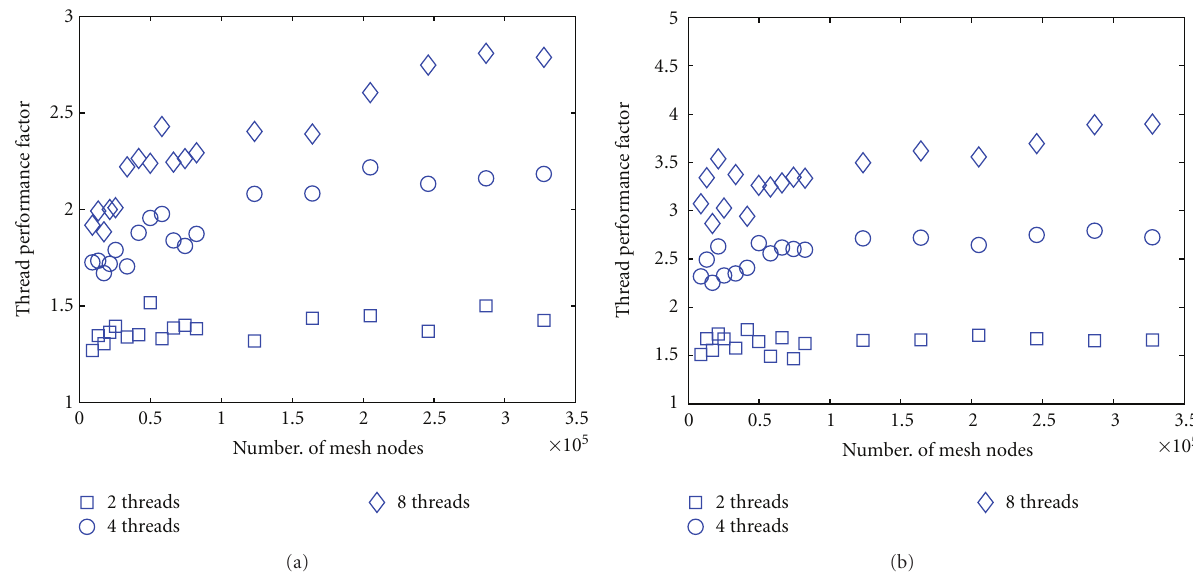
Figure 8: Performance factors for CPU-threaded versus CPU-serial forward solver computations as a function of node densities. (a): CG solver for real-valued problem, (b): BiCGSTAB solver for complex-valued